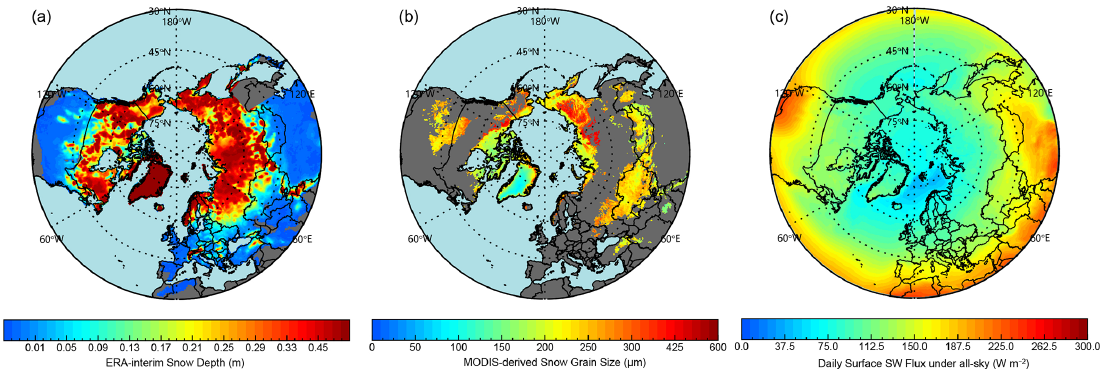
Figure 4. Spatial distributions of 2003–2018 averaged (a) snow depth from ERA-Interim, (d) snow grain size retrieved by MODIS, and (c) total downward shortwave flux at the surface during December–May from CERES.